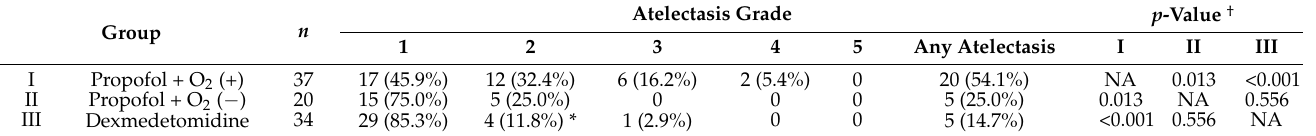
Table 4. Rate of atelectasis occurrence according to the atelectasis grade on final images.